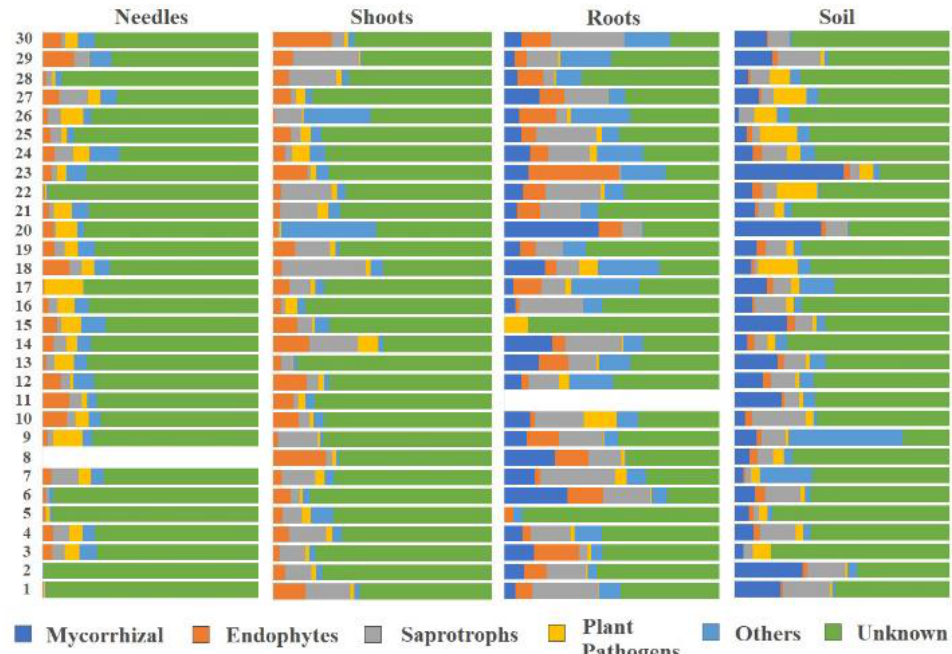
Figure 7. Relative abundance of fungal functional groups in different substrates (needles, shoots, roots, and the soil) of Picea abies. Other represent fungi (animal pathogens), which are not associated with plants. Site numbers to the left are as in Table 1 and Figure 1.